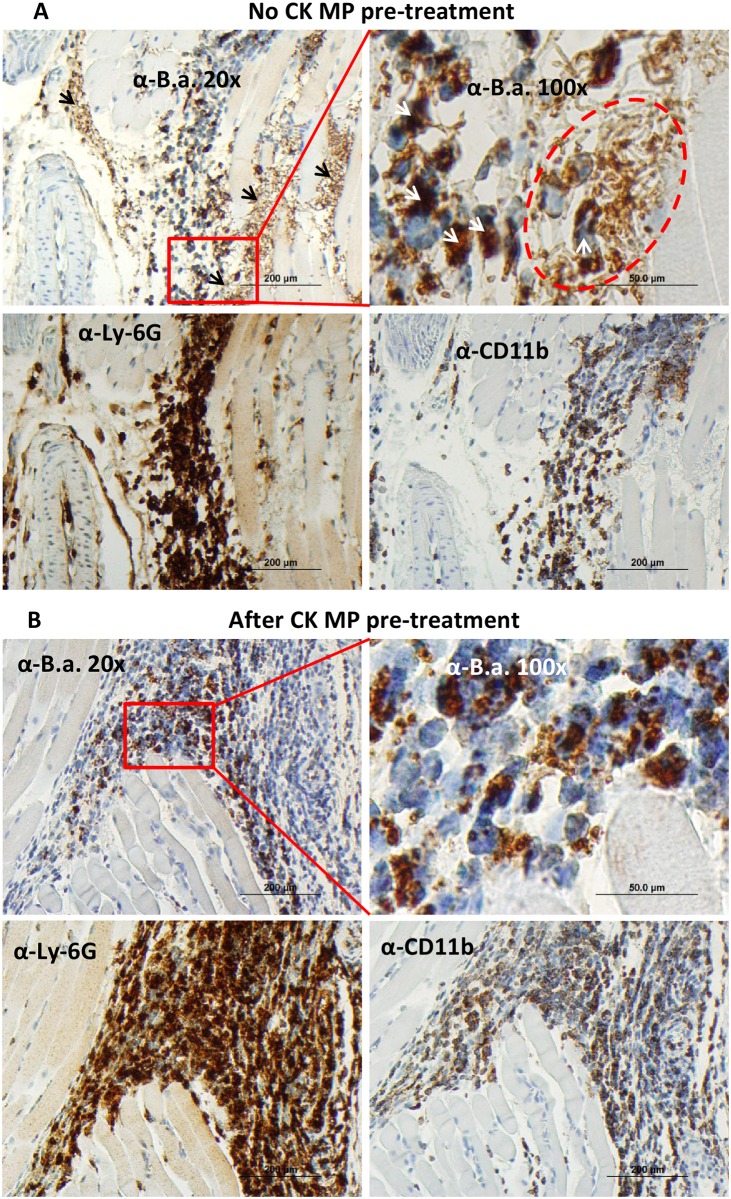
Administration of CK-loaded MPs results in the phagocytic elimination of bacterial burden in the spore-challenged footpads.(A) B.a. infection with spores (4x106 per hind footpad in 20 μl of PBS) after 24 h shows presence of extracellular bacterial chains and intracellular bacterial antigen (brown stain indicated by black and white arrows, correspondingly; top panels). Red square in the left panel identifies a position of a bacterial swarm shown under magnification in the right panel (dotted line) next to the B.a.-positive phagocytes (brown color). Consecutive slices of tissue stained with α-Ly-6G and α-CD11b (A, bottom panels) demonstrate infiltration of phagocytes (brown color) to the site of infection. (B) Pretreatment with CK-loaded MPs for 24 h stimulates an elimination of extracellular bacteria. No extracellular bacteria can be found in the infected tissue (top panels). Red square in the left panel identifies a region magnified in the right panel. Multiple phagocytes stained positive for the B.a. antigens (brown color) are visible. Compared to (A), the consecutive slices of tissue stained with α-Ly-6G and α-CD11b antibodies demonstrate increased infiltration of phagocytes.